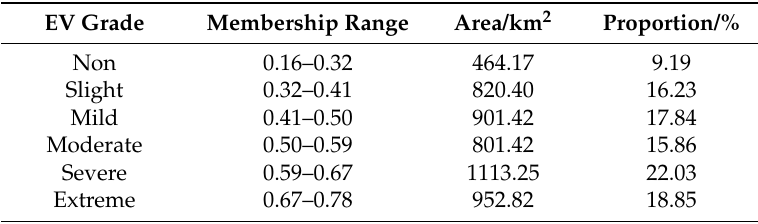
Table 7. Numerical statistics of the different EV